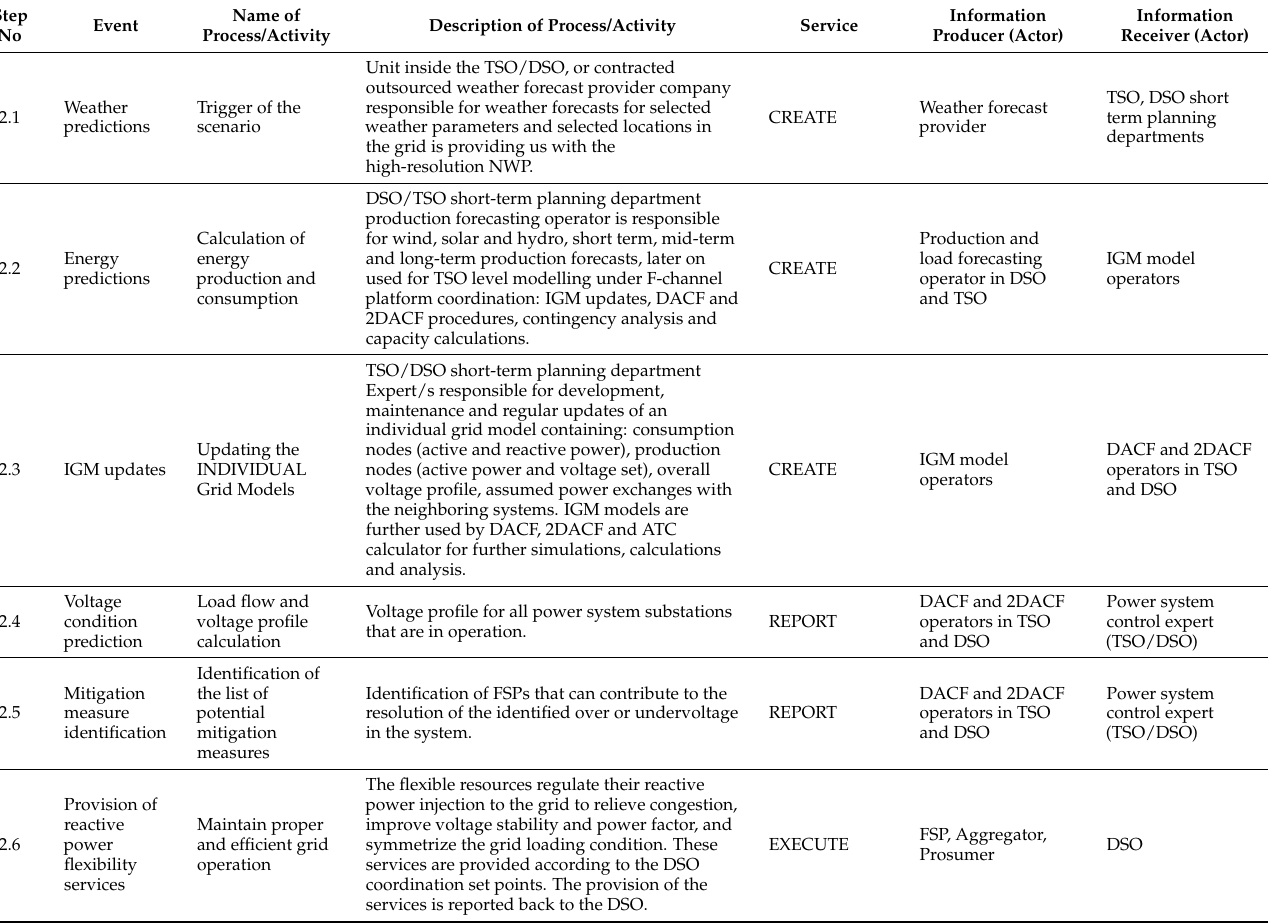
Table 5. Step- by-step analysis of Scenario